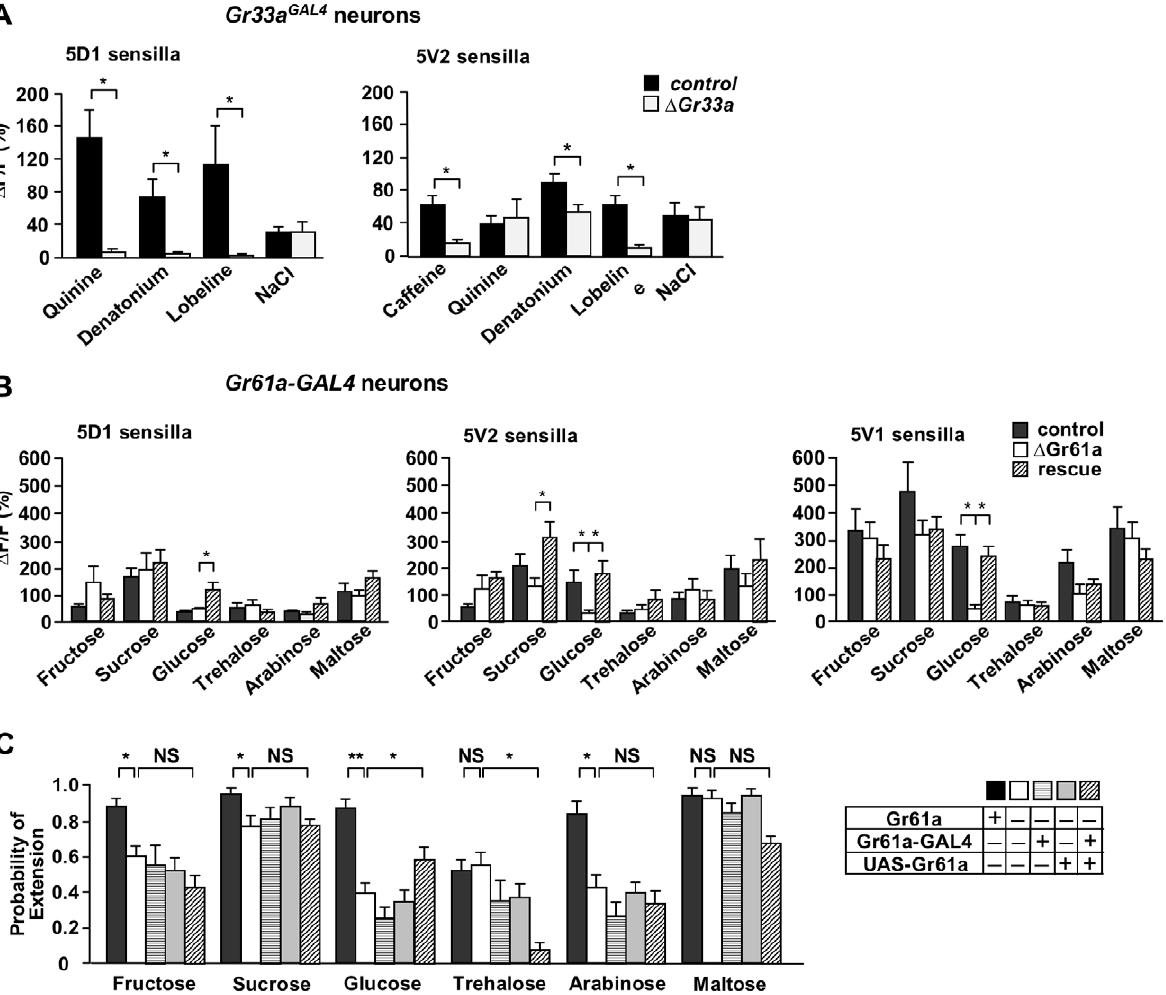
Figure 4. Gr33a and Gr61a are necessary for sensing bitter compounds and glucose, respectively. (A) Gr33a is necessary for sensing all bitter compounds in 5D1- associated bitter/high salt neurons, but not in 5V2- associated neurons. In the latter, response to caffeine and lobeline are largely eliminated in homozygous Gr33a GAL4 mutants, while response to denatonium and quinine are either reduced or unaffected, respectively. Response to high salt was not affected. Concentrations were 10 mM for caffeine, 1 mM for quinine, denatonium and lobeline and 500 mM for NaCl. Genotypes: Gr33a GAL4 /UAS-GCaMP3.0 (control) and Gr33a GAL4 /Gr33a 1 UAS-GCaMP3.0 ( D Gr33a ). 3 , n , 17 for bitter compounds; 4 , n , 8 for NaCl. ANOVA: * p , 0.05, ** p , 0.001. (B) Gr61a is essential for sensing glucose, but not other sugars. Only response to glucose is eliminated in 5V1- and 5V2- associated sweet neurons (note that the 5D1- associated neurons show only a very small response to glucose). While the response to some of the other sugars is slightly reduced (i.e. sucrose and arabinose) in the 5V1- and 5V2- associated neurons of Gr61a mutants when compared to controls, this difference is statistically not significant. Concentrations were 100 mM for all sugars. Genotypes: UAS-GCaMP3.0/Gr61a-Gal4 ; (control), UAS- GCaMP3.0/Gr61a-Gal4; D Gr61a/ D Gr61a ( D Gr61a ) and UAS-GCaMP3.0 UAS-Gr61a/Gr61a-Gal4; D Gr61a/ D Gr61a (rescue). 7 , n , 12. ANOVA: * p , 0.05, ** p , 0.001. (C) PER response to the sugar glucose is significantly reduced in Gr61a mutant flies, but partially rescued by expressing a UAS-Gr61a transgene. Overall reduced PER response to sugars in Gr61a mutants is not due to the lack of the Gr61a gene, since PER does not increase in the rescue flies. Genotypes: wild type: w 1118 (black box), mutants: D Gr61a/ D Gr61a (white box), Gr61a-Gal4 ; D Gr61a/ D Gr61a (horizontal crosshatched), UAS-Gr61a ; D Gr61a/ D Gr61a (gray), and rescue: UAS-Gr61a/Gr61a-Gal4 ; D Gr61a/ D Gr61a (diagonal crosshatched). A single experiment was the result of three to five applications. 11 , n , 20, ANOVA. P , 0.05.